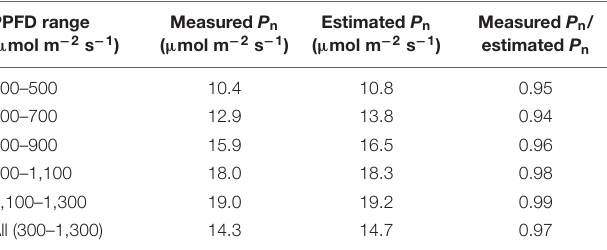
TABLE 1 | The ratio of mean measured P n to mean estimated P n calculated in different PPFD ranges. PPFD range ( µ mol m − 2 s − 1